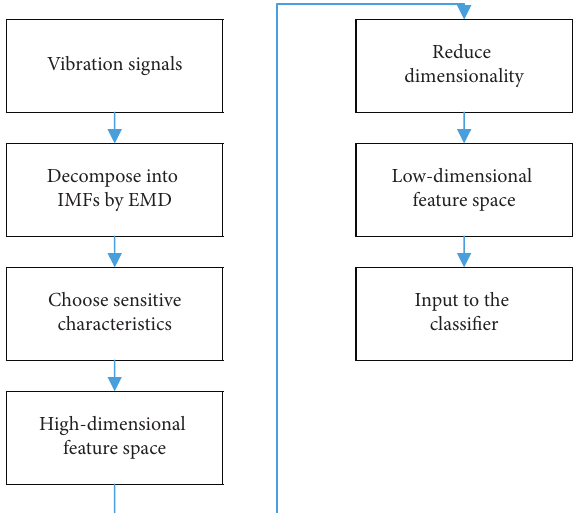
Figure 5: Implementation of the proposed feature extraction